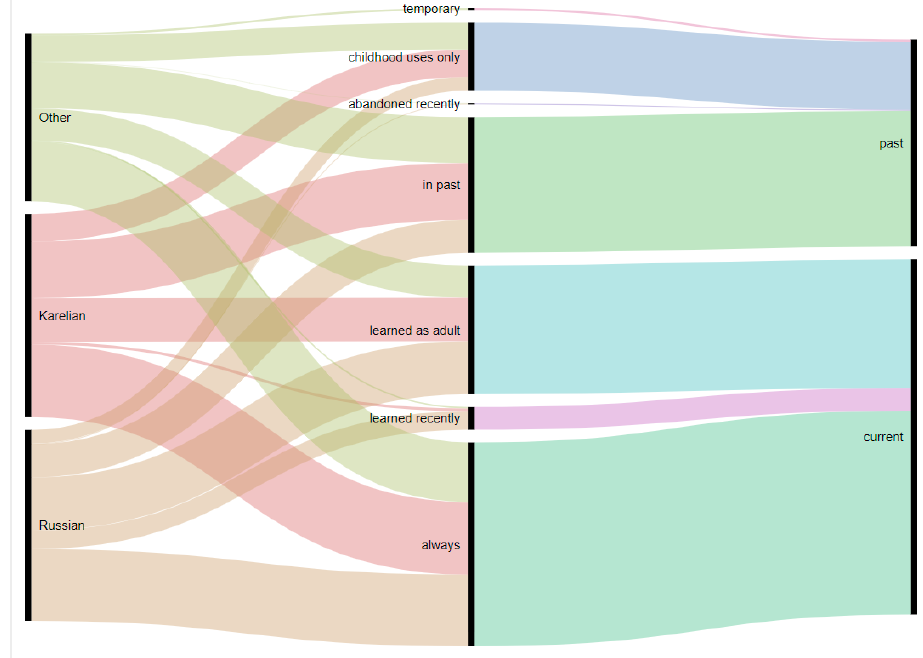
Figure 6. Plant uses in the three groups during the lifetime.